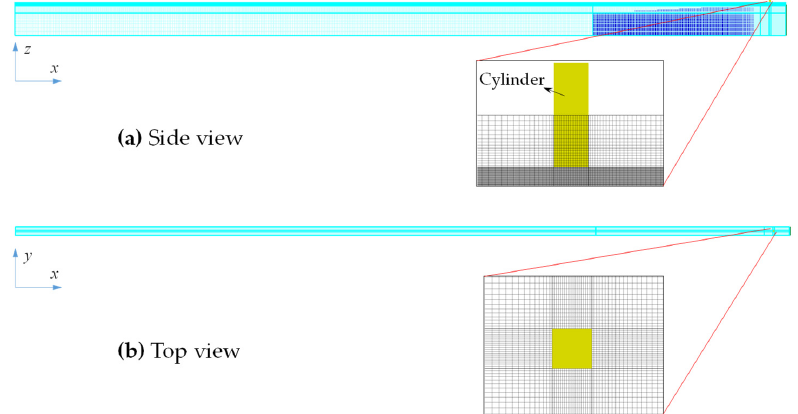
Figure 2. Computational mesh setup and the local refined grid in the vicinity of structure.